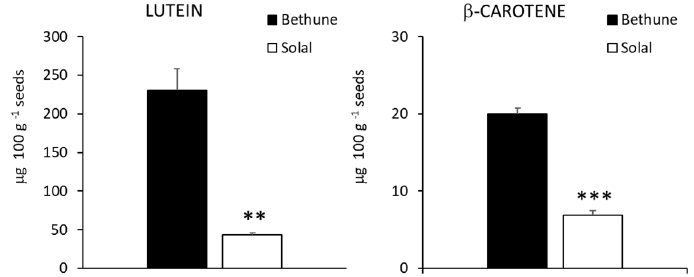
Figure 2. Concentration ( µ g 100 g − 1 seeds) of lutein and β -carotene of the two linseed varieties (Bethune and Solal). ** = 0.01 ≤ p -value < 0.001; *** = p -value ≤ 0.001.